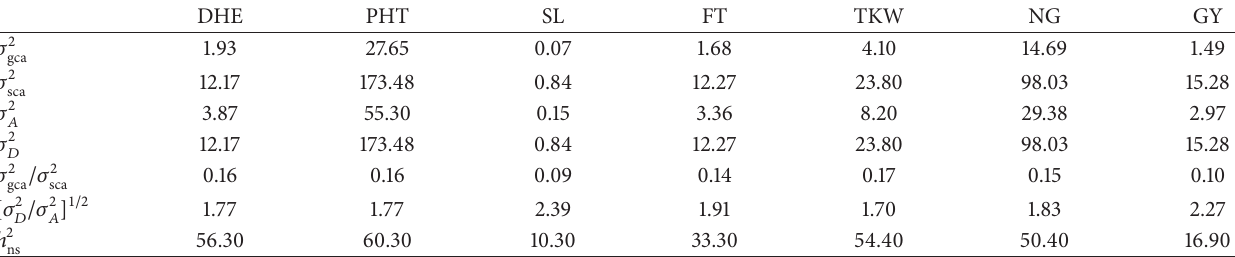
𝜎 2 𝜎 2 ℎ 2 𝜎 2 𝜎 2 𝐴 : additive genetic variance, 𝐷 : dominance genetic variance, ns : narrow sense heritability, gca : estimate of GCA variance, sca : estimate of SCA variance, and 𝜎 2 gca /𝜎 2 sca : average degree of dominance. DHE: number of days to heading, PHT: plant height (cm), SL: spike length (cm), FT: number of fertile tillers, TKW: thousand-kernel weight (g), NG: number of grains per spike, and GY: grain yield